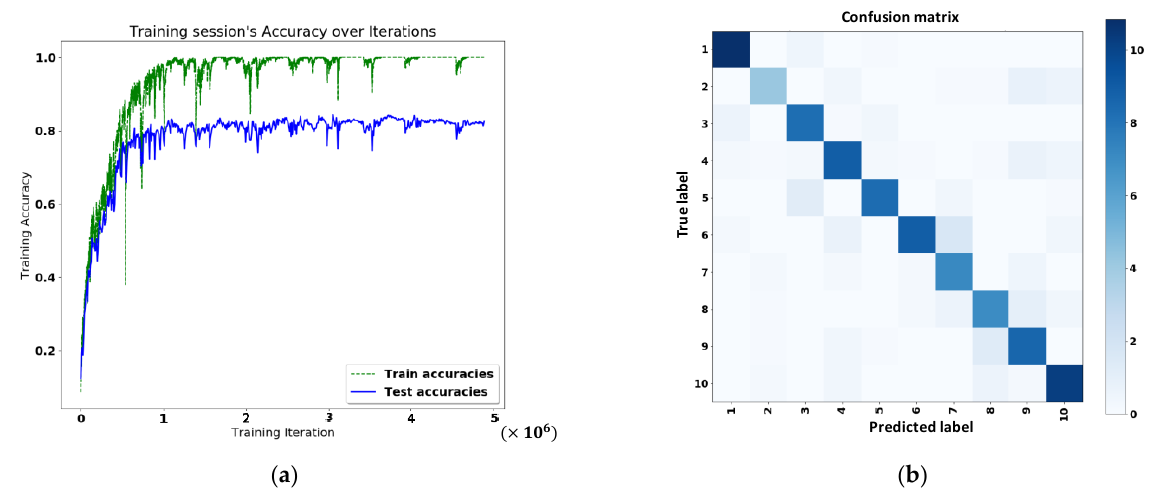
Figure 11. Ten categories of 10 people. ( a ) Training accuracy results; ( b ) classification results.